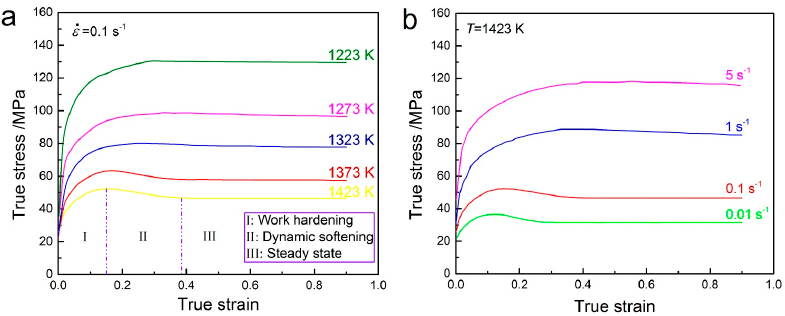
Figure 3. Typical corrected true stress-true strain curves of 70MnSiCrMo carbide-free bainitic steel hot-deformed at ( a ) different temperatures with a strain rate of 0.1 s − 1 and ( b ) different strain rates with a temperature of 1423 K.